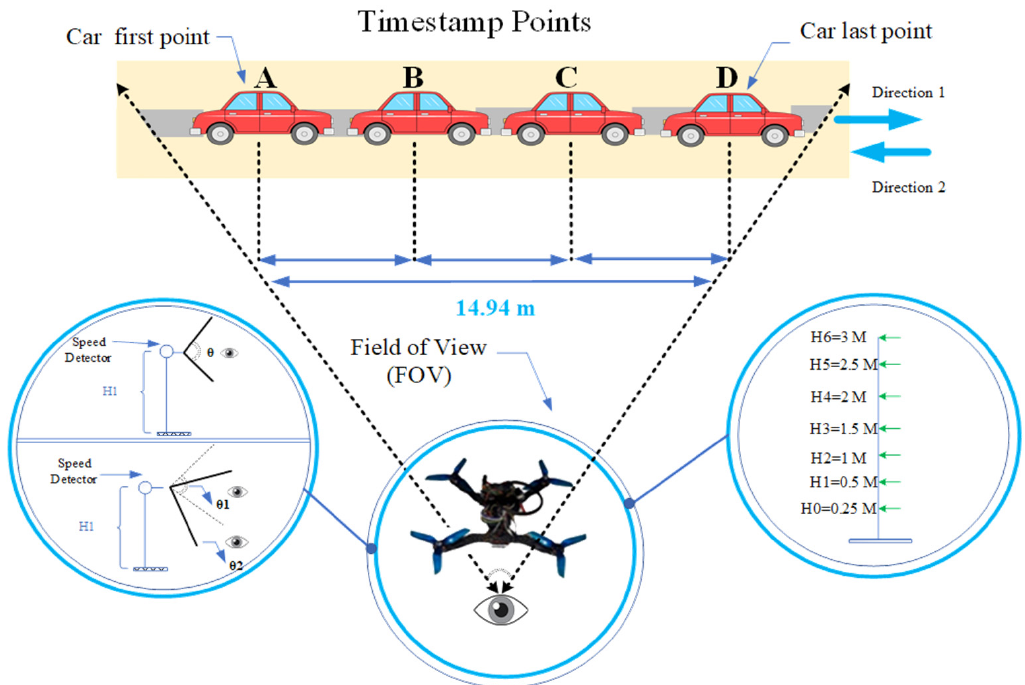
Figure 10. The schematic view of real vehicle tests with various location of A to D.